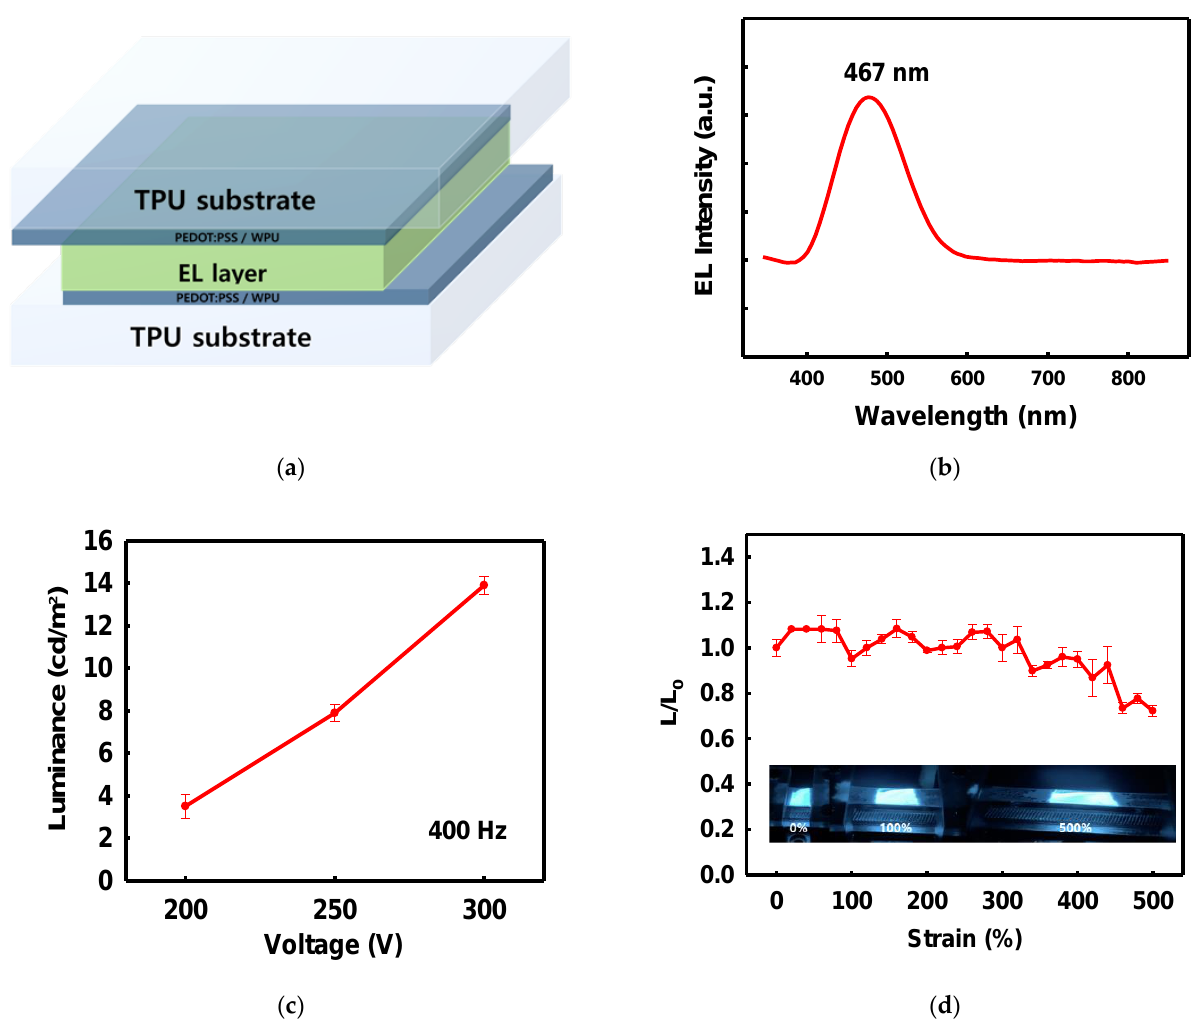
Figure 10. ( a ) Schematic of device structure, ( b ) electroluminescence spectrum of the device, centered at 467 nm, ( c ) luminescence according to voltage change at 400 Hz, ( d ) L/L 0 ratio of the device under strain and photographs of the device under 0, 100, and 500% strain.